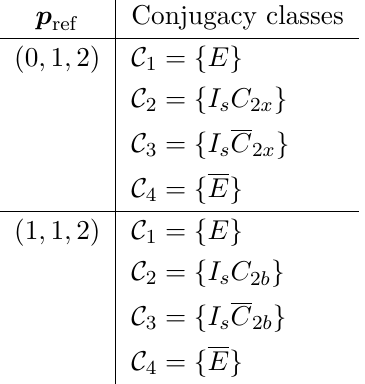
Table 19. The little groups corresponding to reference momentum directions (0 , 1 , 2) and (1 , 1 , 2) are isomorphic to C s . The elements of the double groups C D for these momenta directions are s listed above, grouped into conjugacy classes. E is the identity element, E represents a rotation by 2 π about any axis, and G = EG for each element G in C s . Spatial inversion is denoted by I s .